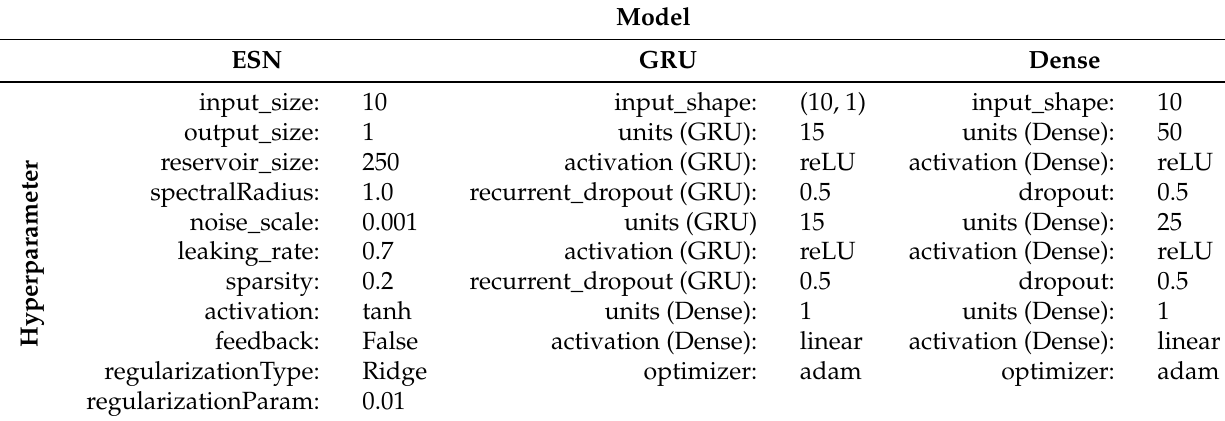
Table 2. Models setting used for strategy B.